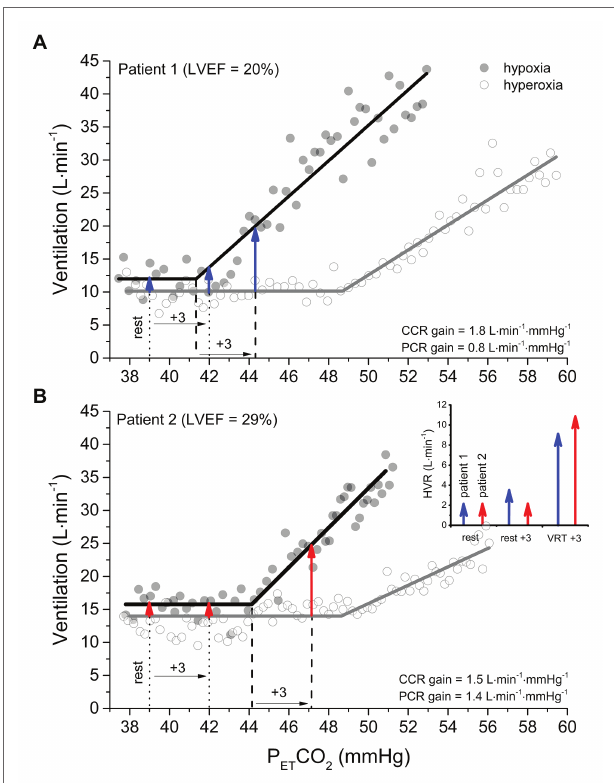
FIGURE 2 | A comparison of isoxic hyperoxic (PO 2 = 150 mmHg) ventilatory responses to CO 2 ( white circles and gray lines) with isoxic hypoxic (PO 2 = 50 mmHg) ventilatory responses to CO 2 ( black circles and black lines) between two patients with heart failure with reduced ejection fraction. Note that the gain (or sensitivity) is less in patient 1 (A) vs patient 2 (B) . However, the ventilatory recruitment threshold (VRT) for the peripheral chemoreflex (PCR) occurs at a higher PCO 2 in patient 2 vs. 1. The arrows provide an estimation of the HVR attributable to the PCR at isocapnic PCO 2 corresponding to rest, +3 mmHg above rest, and + 3 mmHg above the VRT for patient 1 ( blue arrows) and patient 2 ( red arrows). After determining the ventilation at an isocapnic PCO 2 in hyperoxia to measure the central chemoreflex (CCR) contribution, hypoxia is introduced, and the ventilation measured again at the isocapnic PCO 2 . Because patient 2 has a great VRT than patient 1, the HVR corresponding isocapnic PCO 2 at rest and + 3 mmHg above rest incorrectly indicate that the PCR sensitivity of patient 1 is the same or greater than patient 2. By contrast, when hypoxia is introduced at an isocapnic PCO 2 of +3 mmHg above the VRT, the HVR correctly reveals the PCR gain of patient 2 is greater than patient